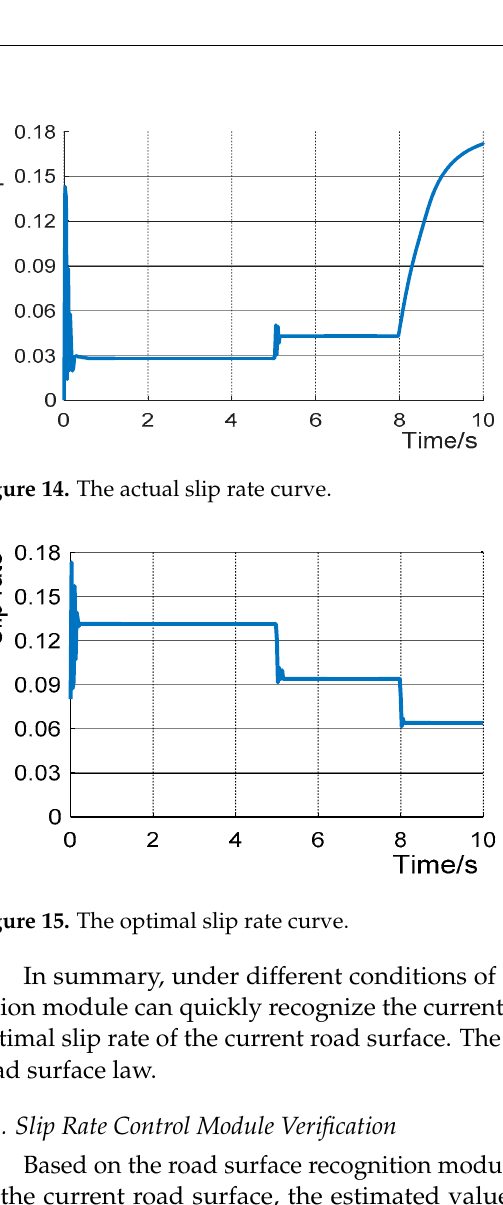
Figure 13. Road adhesion curve.